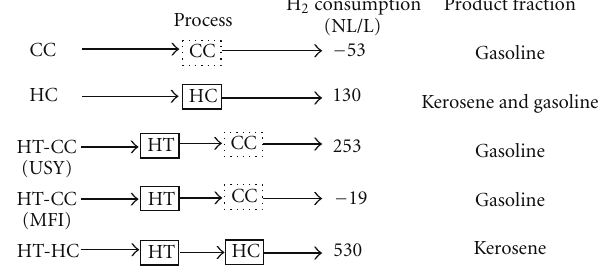
Figure 16: Evaluation of